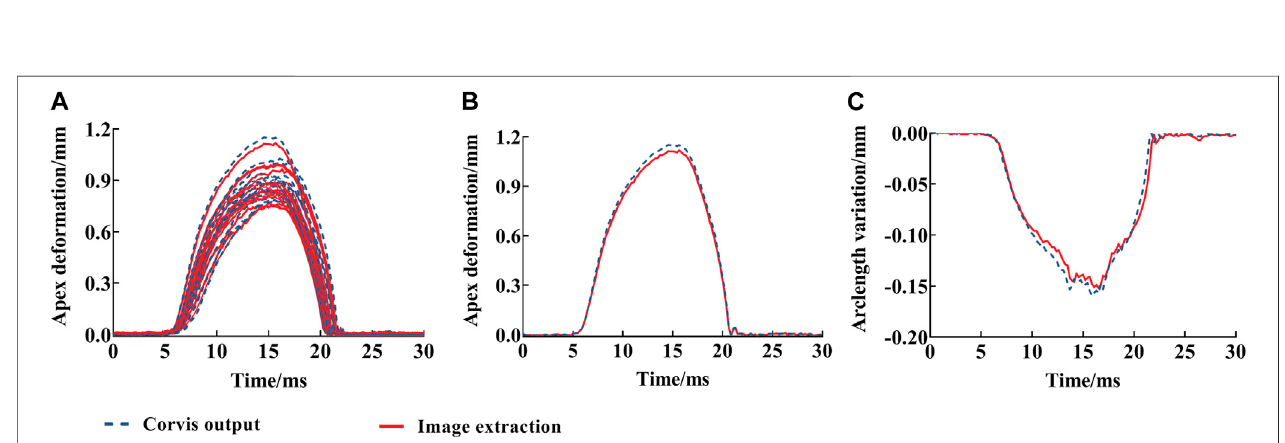
FIGURE 6 | De fl ection amplitude and arc length variation of corneal anterior surface vertices from image extractions with time: de fl ection amplitude of all eyes (A) , one eye (B) , and arc length variation (C) . The red solid line is the image extraction result; blue dotted line is the de fl ection amplitude from Corvis ST.